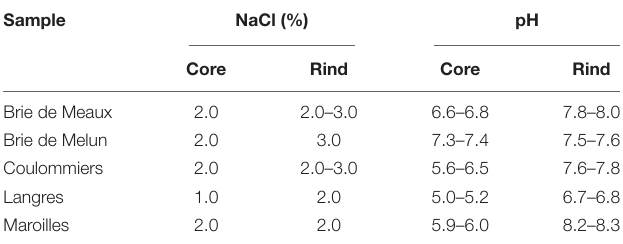
TABLE 1 | The salinity and pH of five kinds of cheese samples.